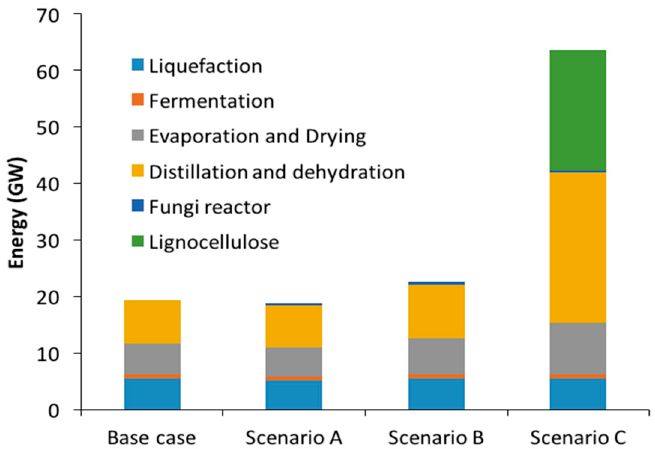
Figure 3. Section-wise energy consumption for different scenarios in comparison with the existing industrial setup.